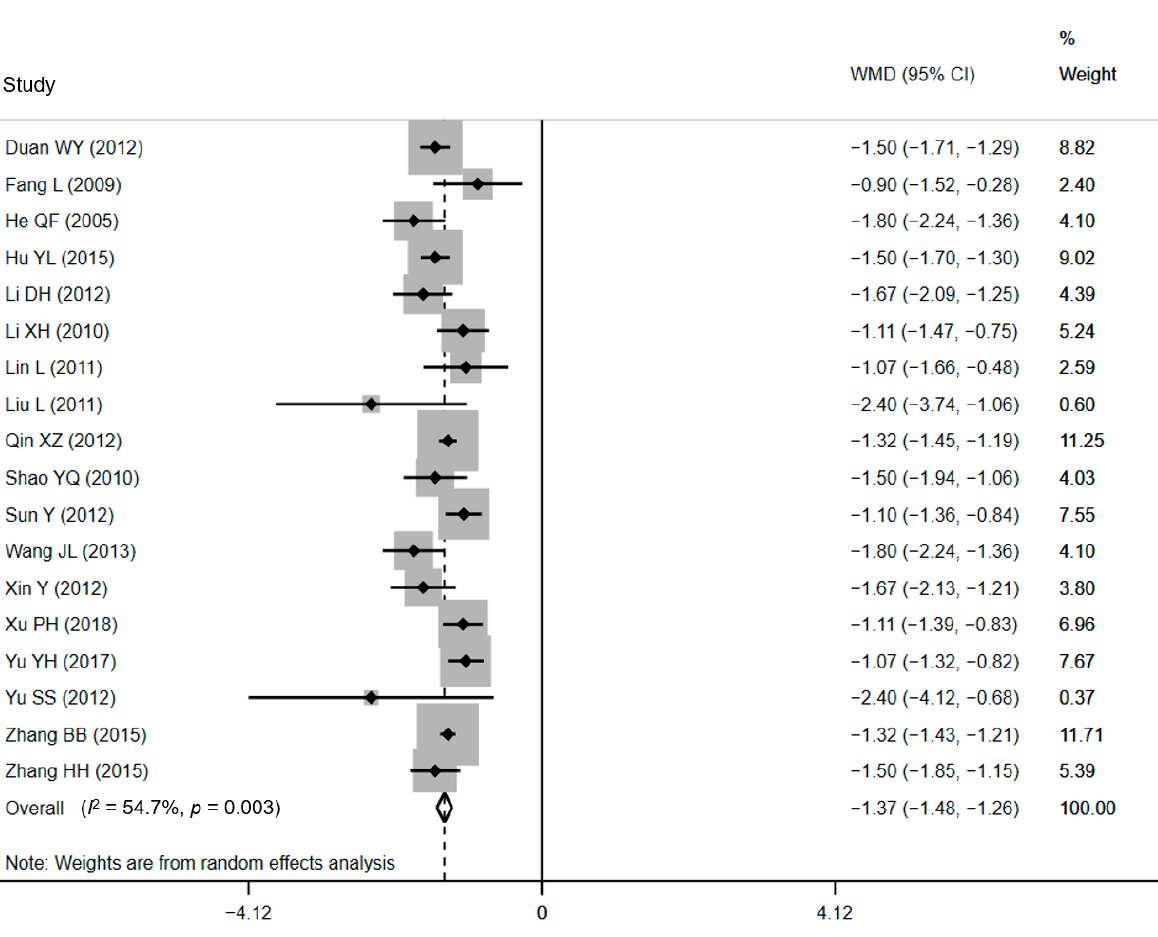
Figure 2. Forest plot of effects on LOS. Abbreviations: WMD, weighted mean difference; CI, confidential interval; LOS, length of stay.